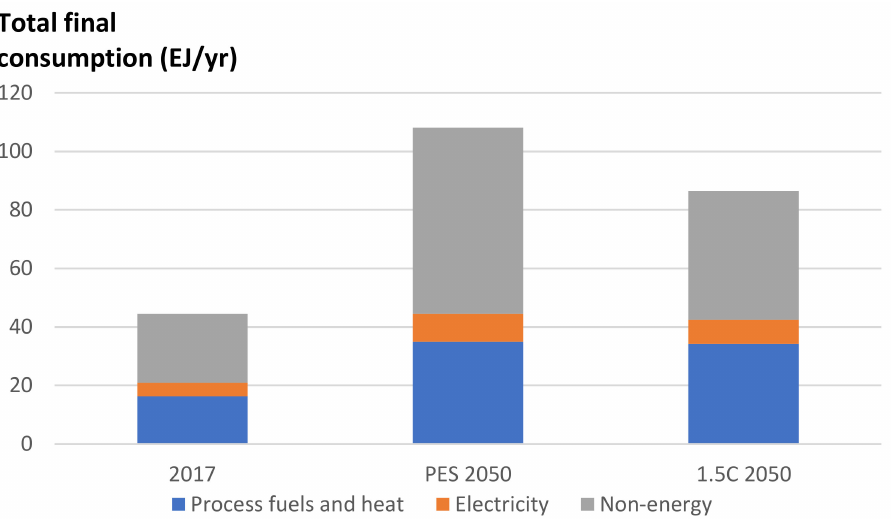
Figure 3. Development in the estimated total final consumption of the global chemical and petro- chemical sector between 2017 and 2050.